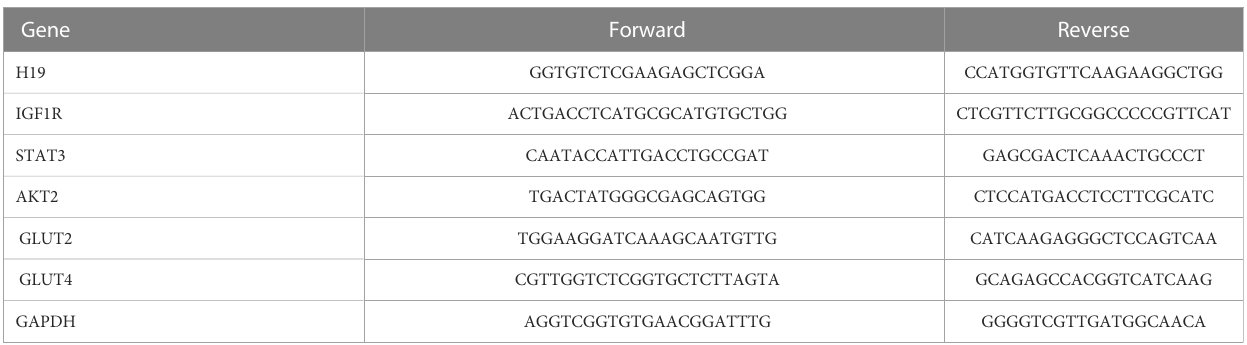
TABLE 2 Primers for real-time quantitative PCR of mouse tissues.